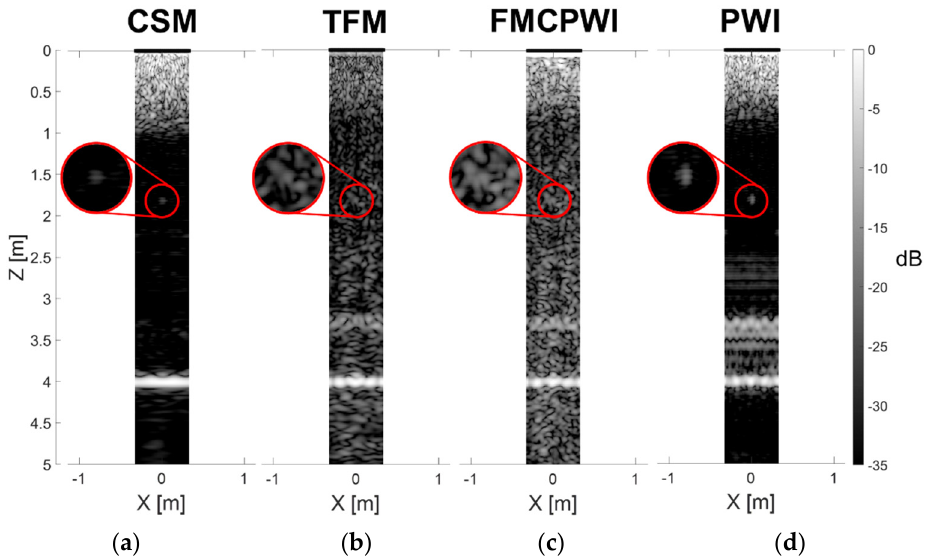
Figure 12. Comparison of unwrapped pipe reconstructions of 0.2 λ SH0 long, 50% through wall thickness deep notch at 1.8 m axial distance from the array using ( a ) CSM, ( b ) filtered TFM, ( c ) filtered FMCPWI and ( d ) PWI, from experimental data.